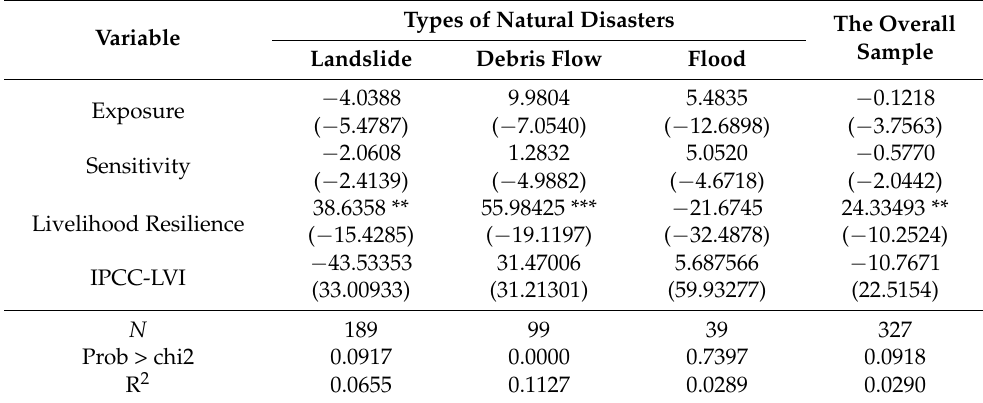
Table 5. Regression results of household livelihood vulnerability and livelihood-strategy choice in different disaster-type-threatened areas. (Source: the author, 2021).